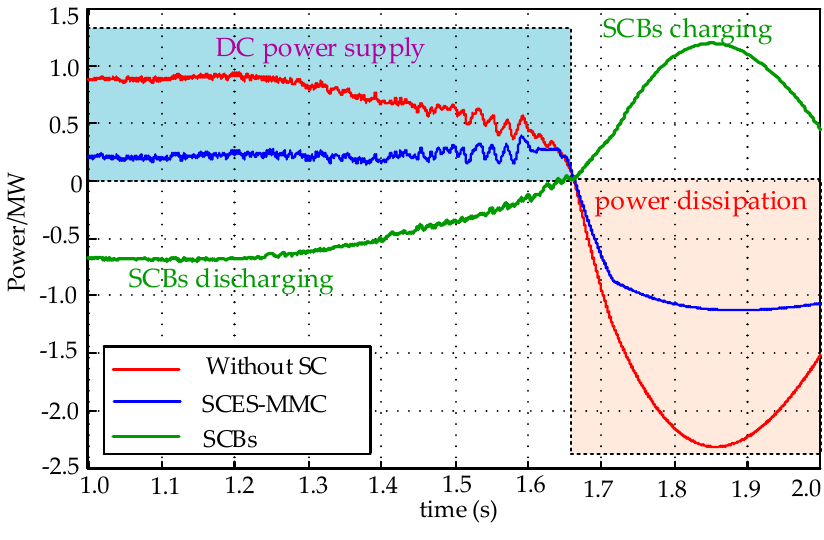
Figure 8. Output performance of SCES-MMC: ( a ) AC output voltage; ( b ) AC output current; ( c ) Motor speed; ( d ) Average SOC of SCBs; ( e ) Voltage of the SCBs — phase a; ( f ) Voltage of the SCBs — phase b.